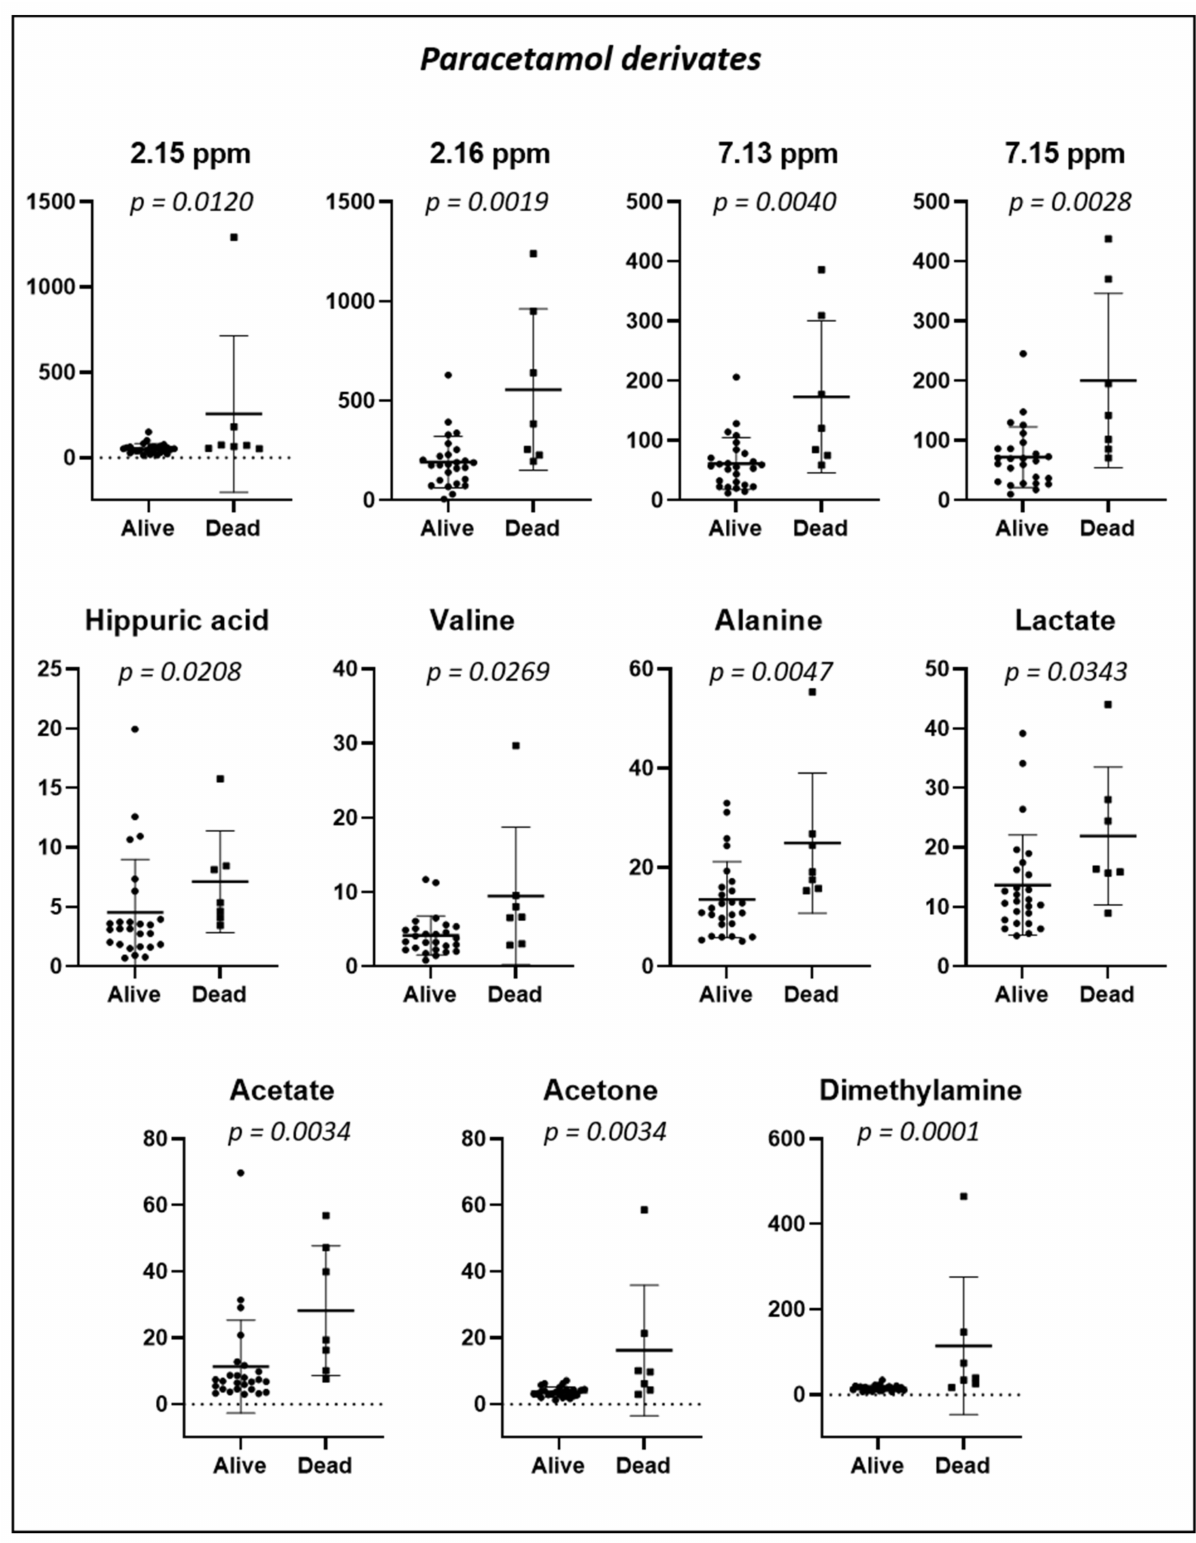
Figure 9. Dot plots of targeted metabolites showing significant differences in urinary concentration in specimens collected at baseline from 33 patients according to whether they were alive (n = 26) or died (n = 7) during the 24-month study period. Plots represent mean ± standard